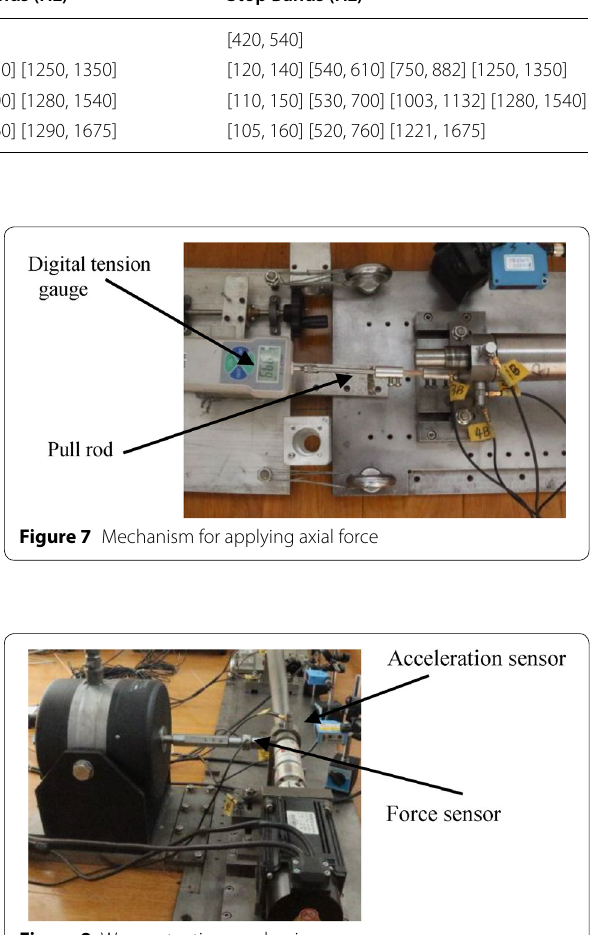
Figure 8 Wave actuating